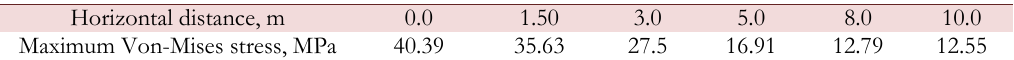
Table 7: The maximum Von-Mises stress with different horizontal distances.